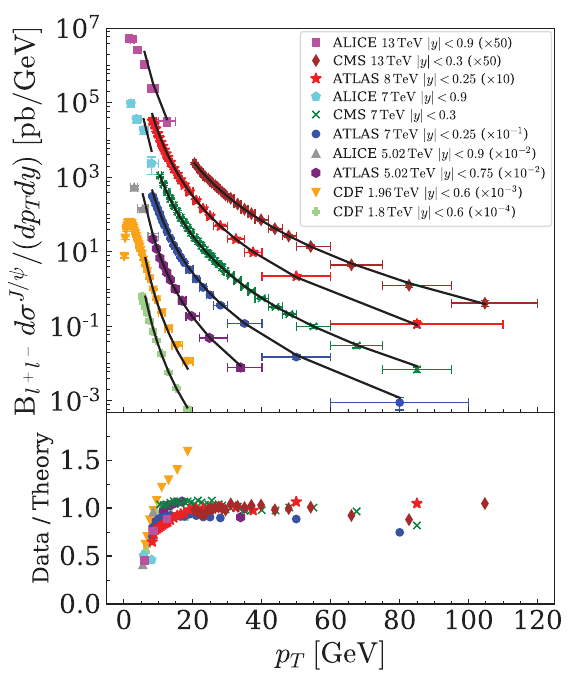
Figure 3. (Upper): Theoretical calculations for the differential cross section of prompt J /ψ pro- duction at mid rapidity in hadronic collisions at collider energies. Experimental data are taken from Refs. [ 11–18 ] . (Lower): Ratios of mean points of collider data to theoretical predictions in the same p bin for prompt J /ψ production, obtained from the upper T